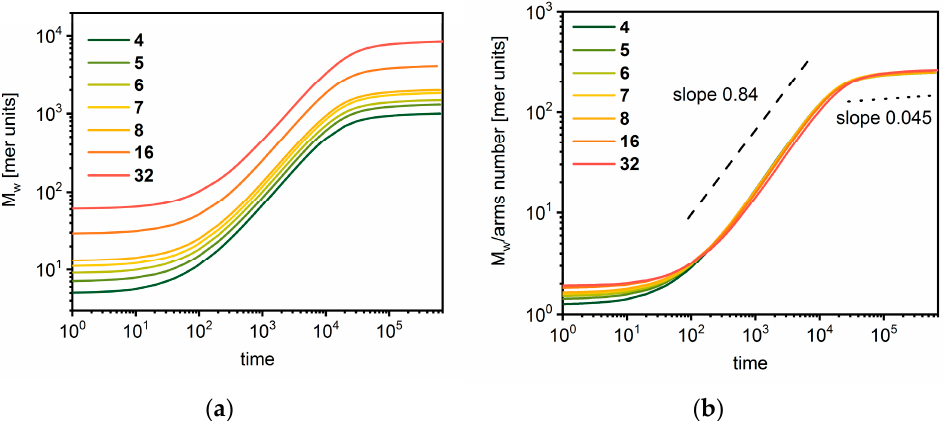
Figure 3. Average total mass ( a ) and average mass of arm ( b ) of star-branched polymer as a function of time. The number of arms is given in the legend.